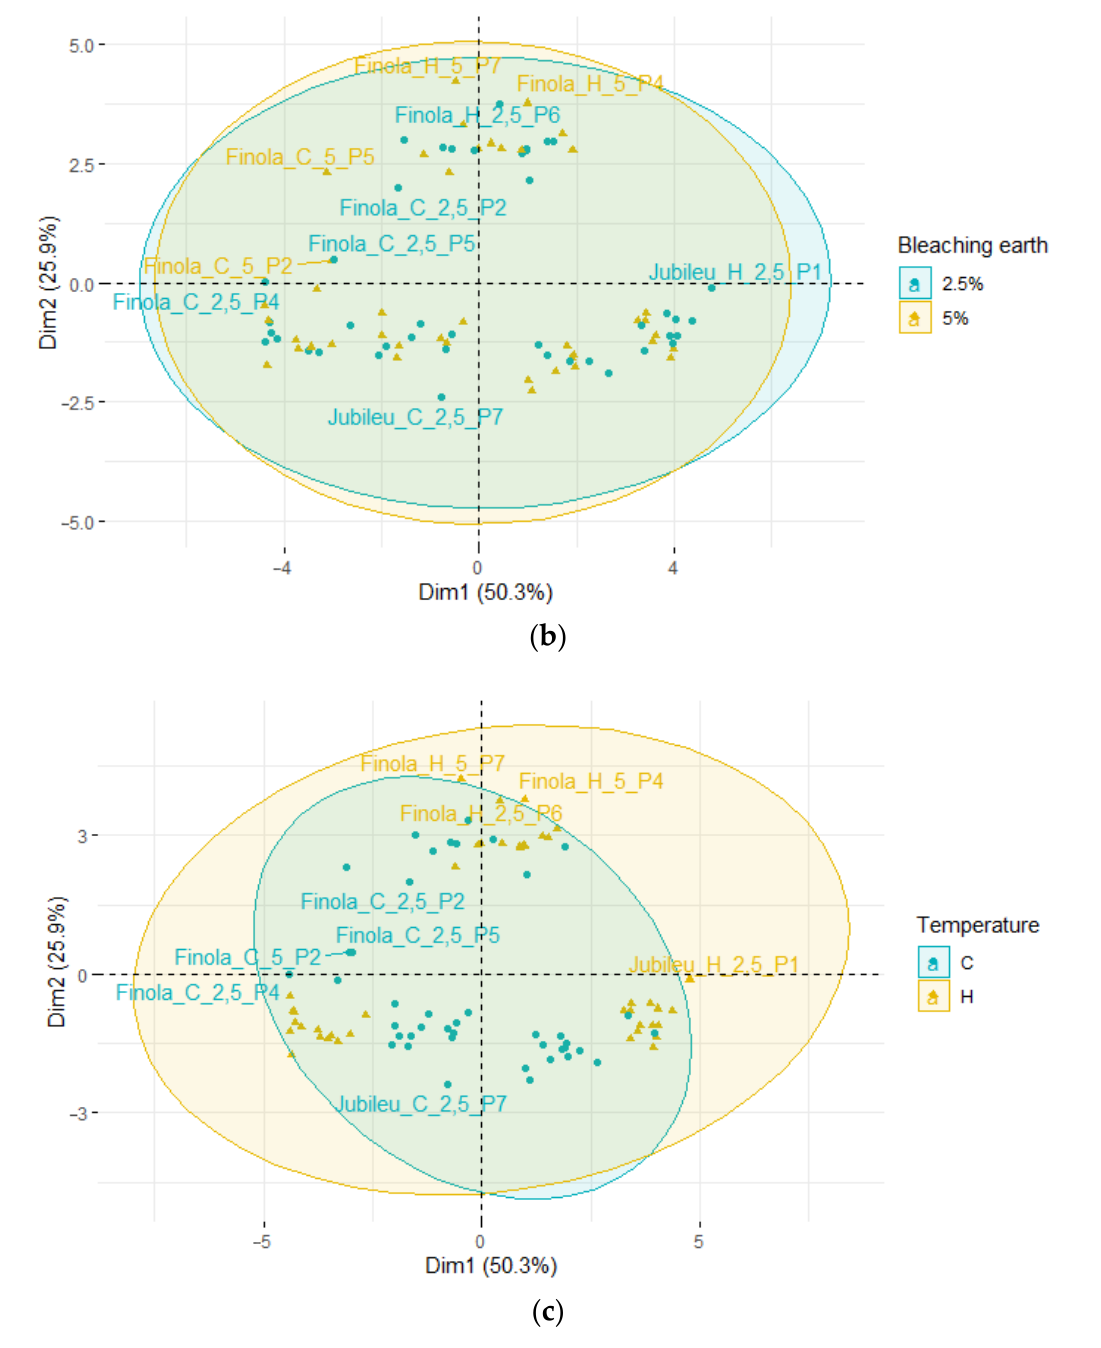
Figure 1. Principal component analysis (PCA) of the loading plot and score plots of data from the fatty acid profiles of bleached hemp oils, where: ( a ) grouped oil type; ( b ) grouped amounts of BE; ( c ) grouped temperature of pressed seeds.